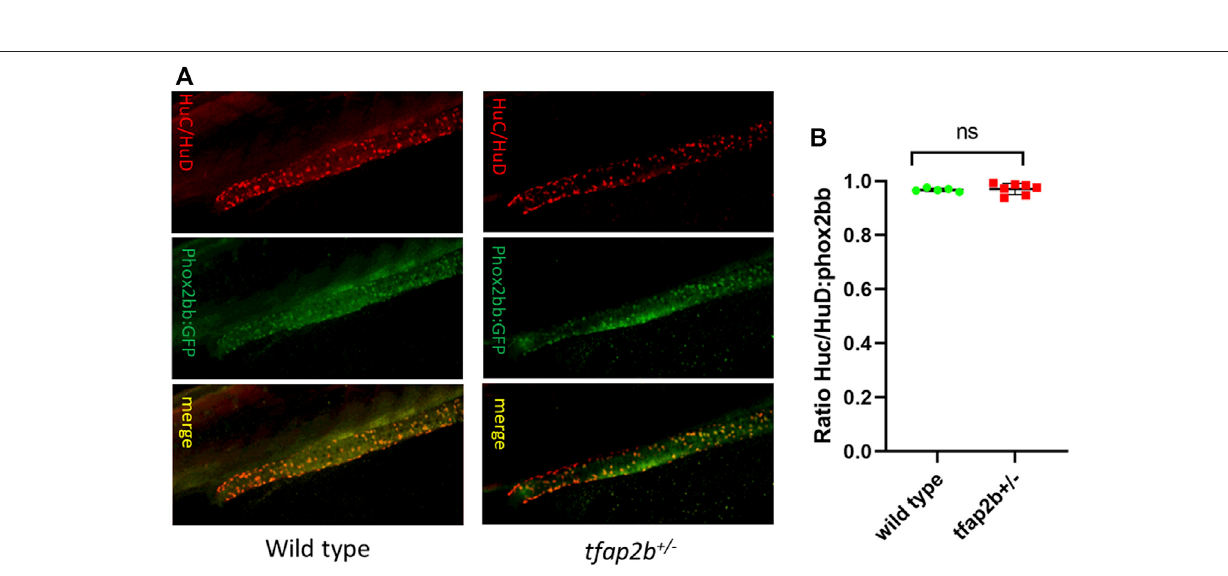
Frontiers in Cell and Developmental Biology |